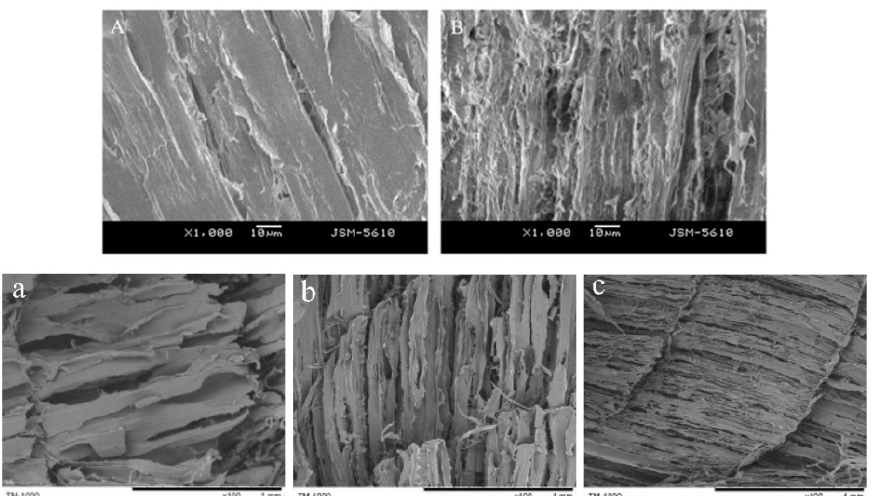
Figure 3. Effects of ice crystals on the structure of aquatic products. The SEM micrographs of peeled shrimp( A : fresh and B : freezing in a freezer at − 30 ◦ C) and hairtail ( a : conventional air freezing at − 20 ◦ C, b : refrigerator cryogenic freezing at − 80 ◦ C, and c : liquid nitrogen immersion freezing at − 196 ◦ C) are adapted from Zhang et al. [118] and Luan et al. [119], respectively.